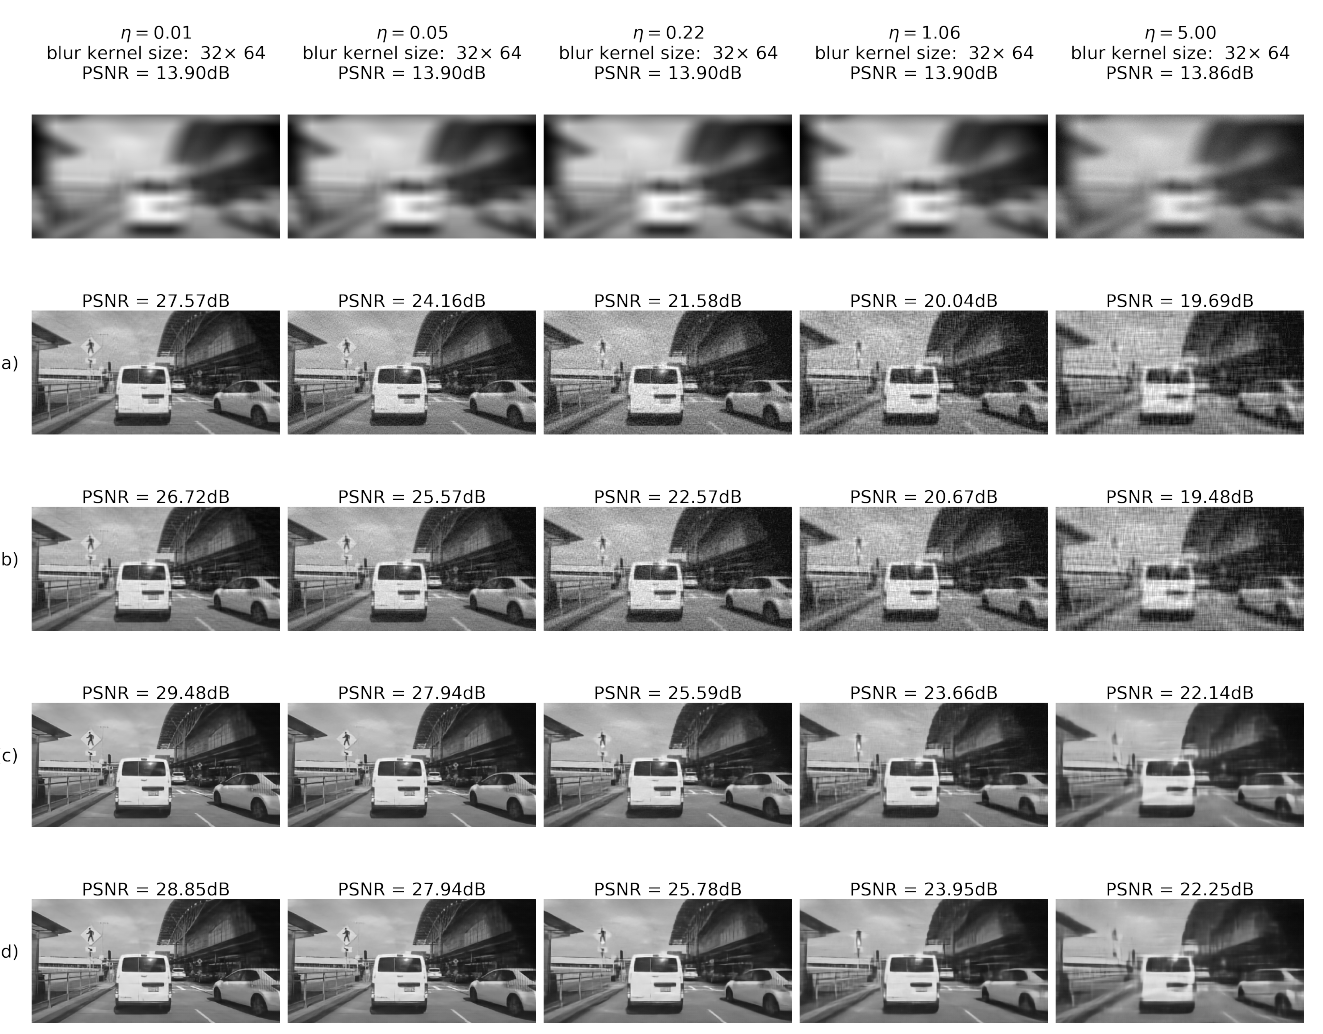
Figure 17. Deblurring using Wiener deconvolution: ( a ) RD output before E2E training; ( b ) RD output after E2E training; ( c ) IEN output before E2E training; ( d ) IEN output after E2E